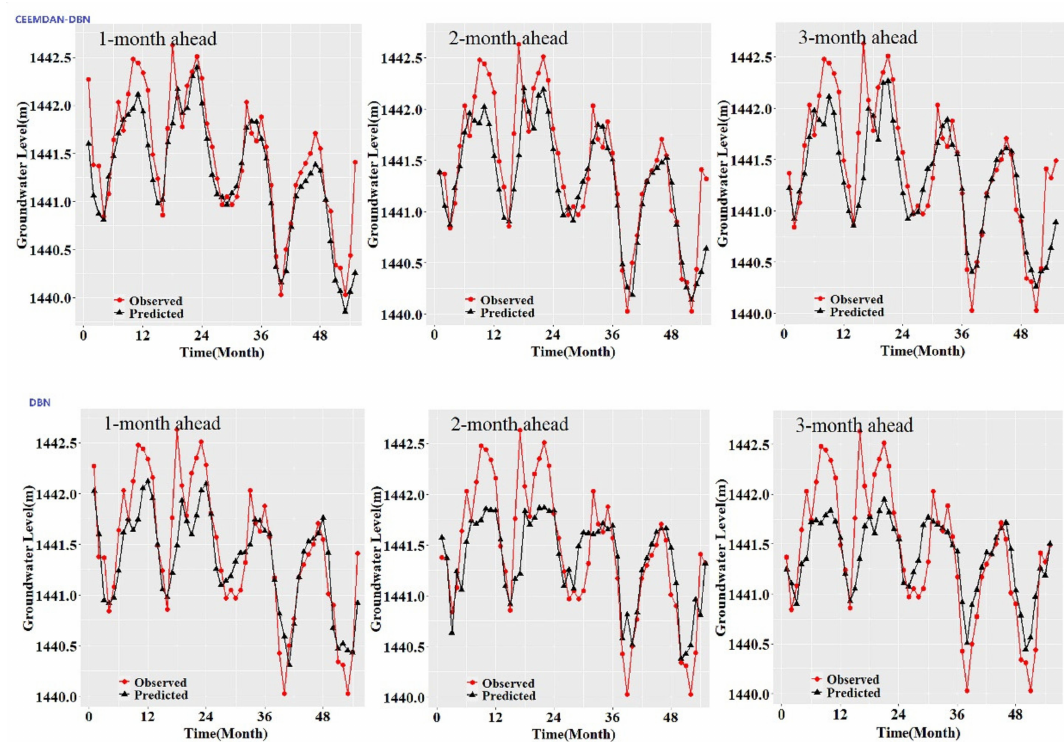
Figure 3. Observed vs. predicted groundwater level for Well I generated by the CEEMDAN-GA-DBN, CEEMDAN-DBN and DBN models for 1-, 2- and 3-month ahead forecast in the testing period.